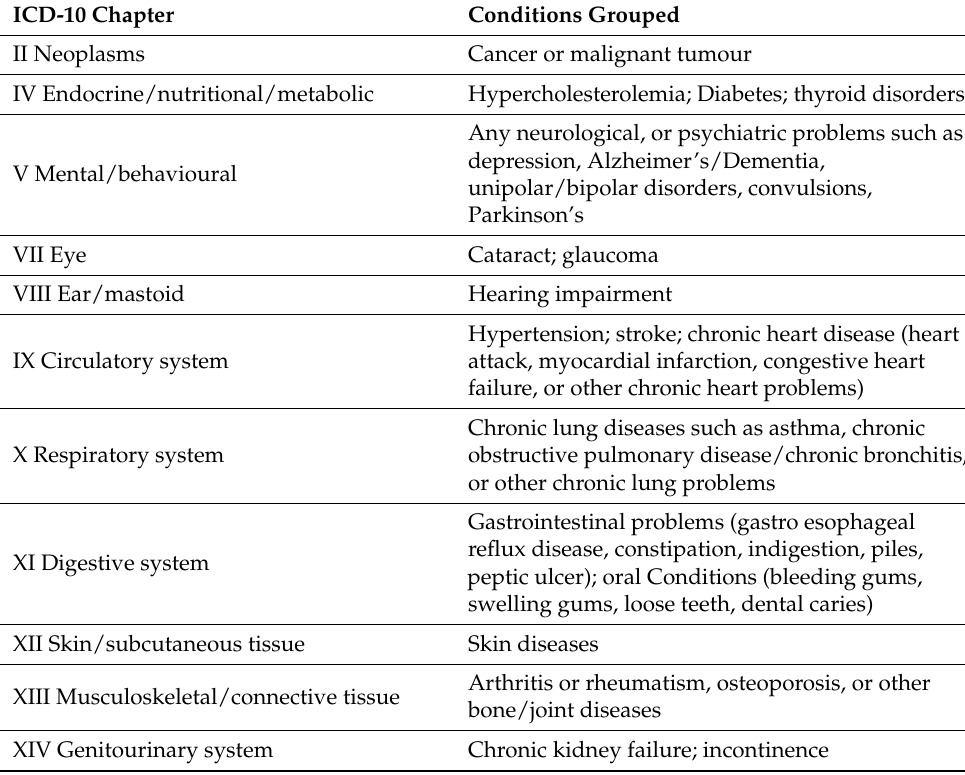
Table 1. Conditions grouped by ICD-10